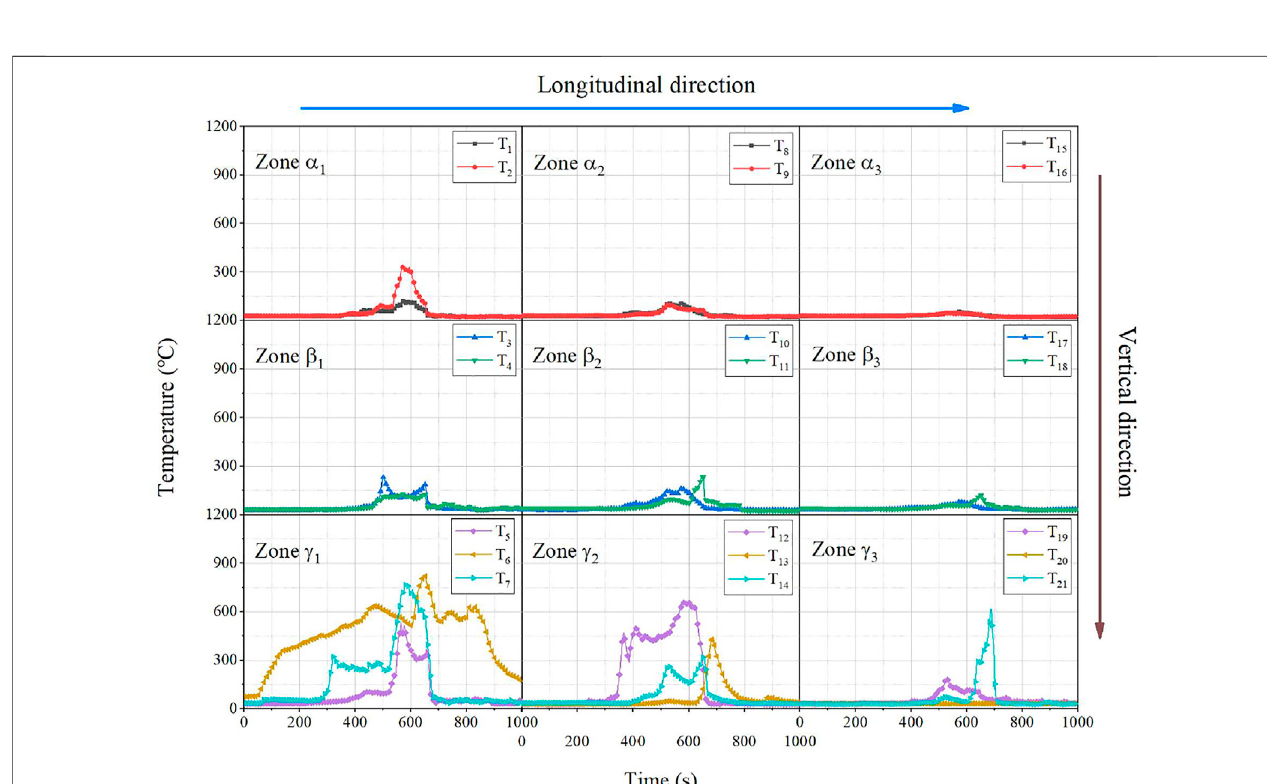
FIGURE 9 | Temperature curves outside the PHEV in test